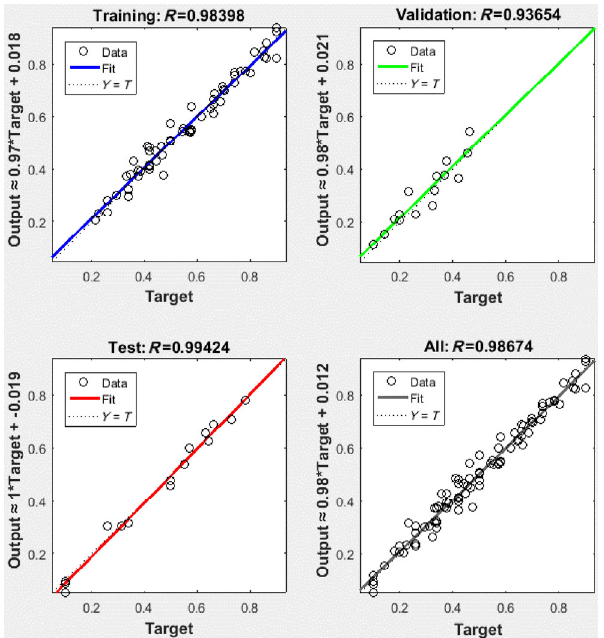
Fig. 15 Regression plot of optimized SHL-ANN architecture (Network No. 21).